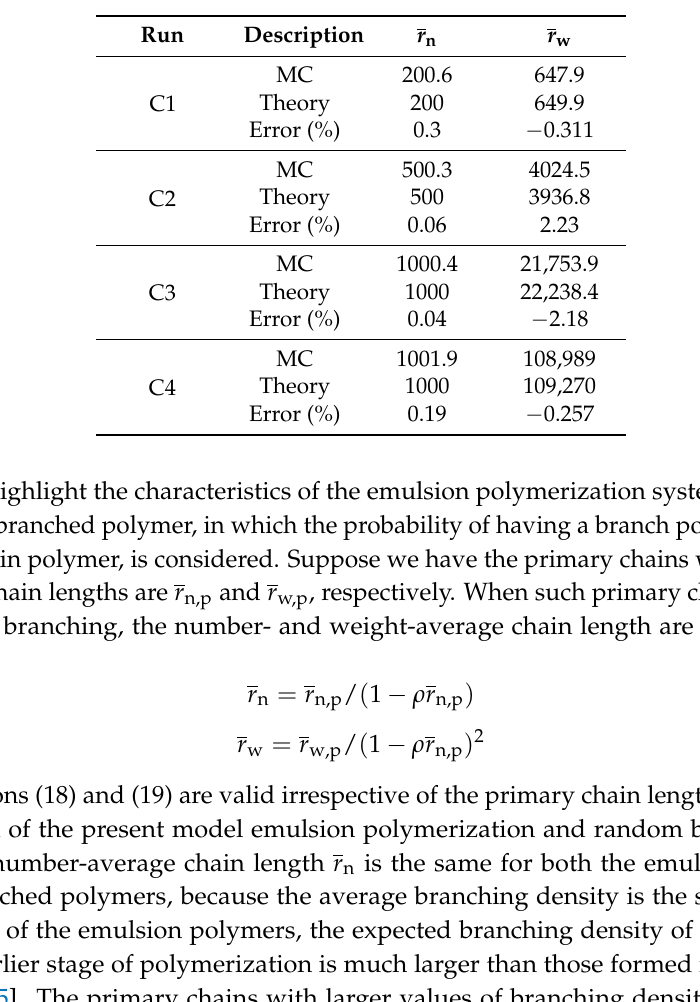
Table 4. Comparison of the calculated average chain